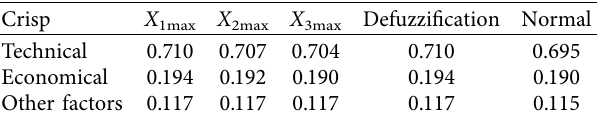
Table 4: Defuzzification of calculated normalized weights of the main study